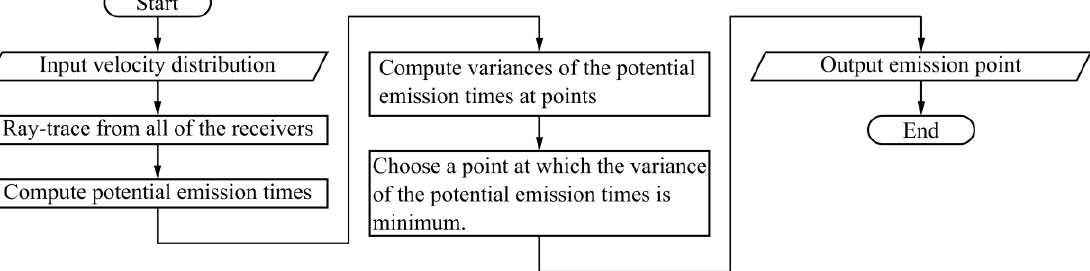
Figure 2. Conceptual flow diagram of the conventional source localization technique based on the ray-trace technique.